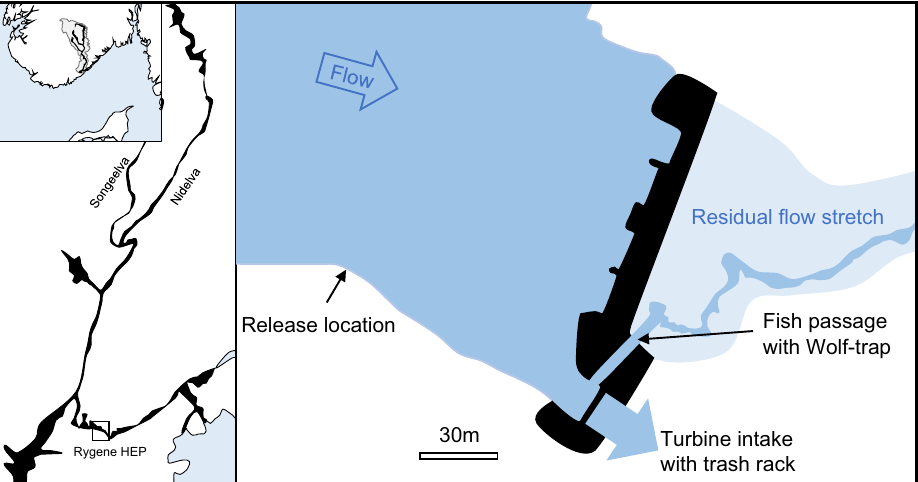
Figure 1. The watercourse of river Nidelva (upper) including the anadromous stretch with the Songeelva tributary (mid) and Rygene hydropower station with release location of tagged smolts, dam, turbine intake and fish passage.